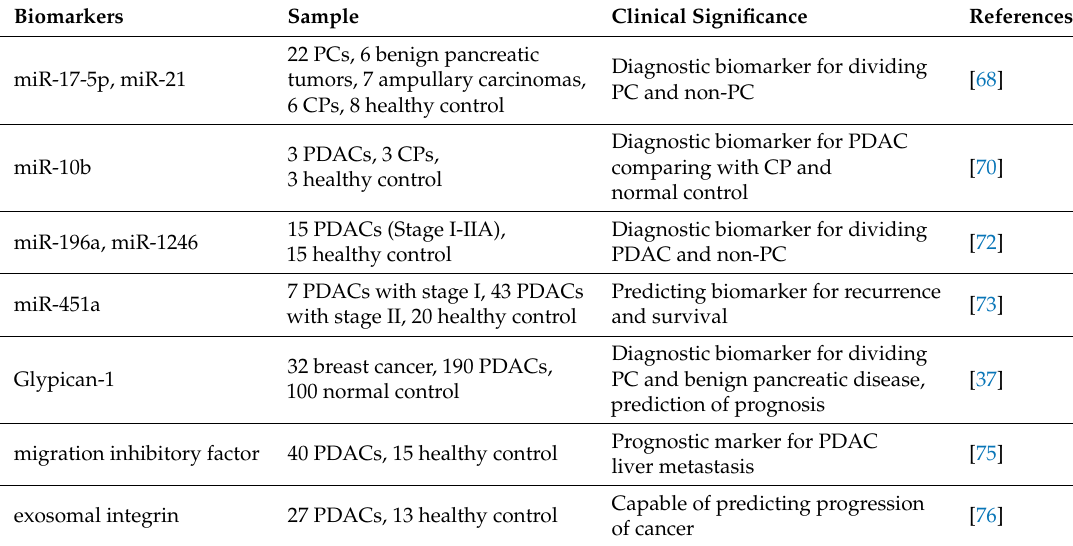
Table 2. Exosomes as biomarkers in